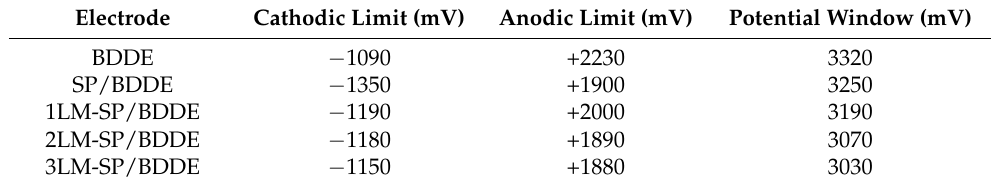
Table 1. The usable potential window of particular electrodes in 0.1 mol L − 1 H 2 SO 4 (the limit was set to a current density value of +2000 nA mm − 2